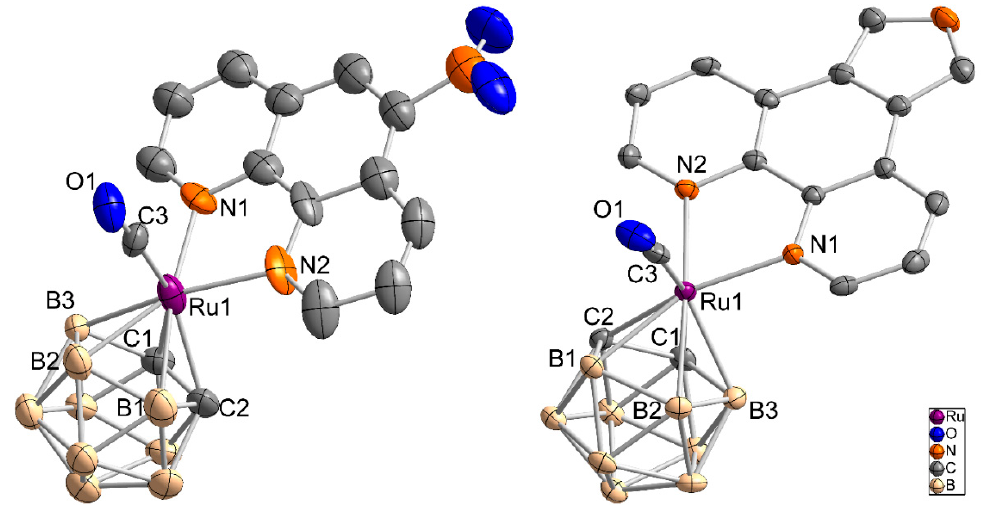
Figure 3. Molecule structure of [3-(CO)-3,3-( L2 - κ 2 N,N )- closo -3,1,2-RuC 2 B 9 H 11 ] ( 2 ) ( left , only the S enantiomer is shown) and [3-(CO)-3,3-( L4 - κ 2 N,N )- closo -3,1,2-RuC 2 B 9 H 11 ] ( 4 ) ( right ) as an ellipsoid-stick model with thermal ellipsoids at 50% probability level. Solvent molecules and hydrogen atoms are omitted for clarity. Table 1. Selected bond lengths (in pm) and angles (in °) in 2 , 4 , and 5 in comparison with [3-CO-3,3-